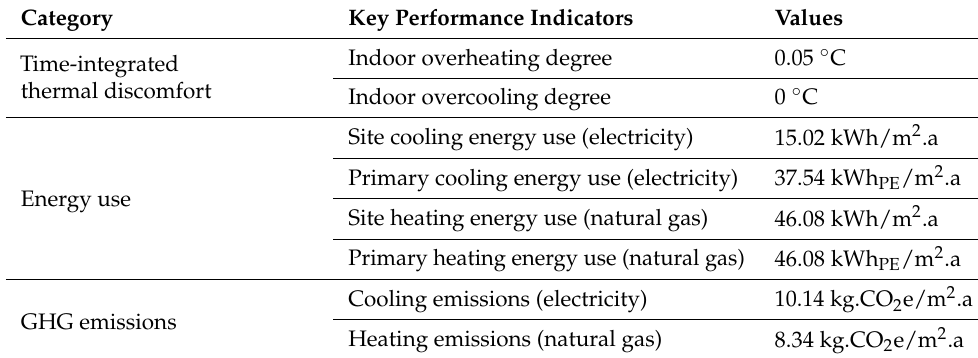
Table 3. Performance evaluation of the reference building from May 2018 to April 2019.